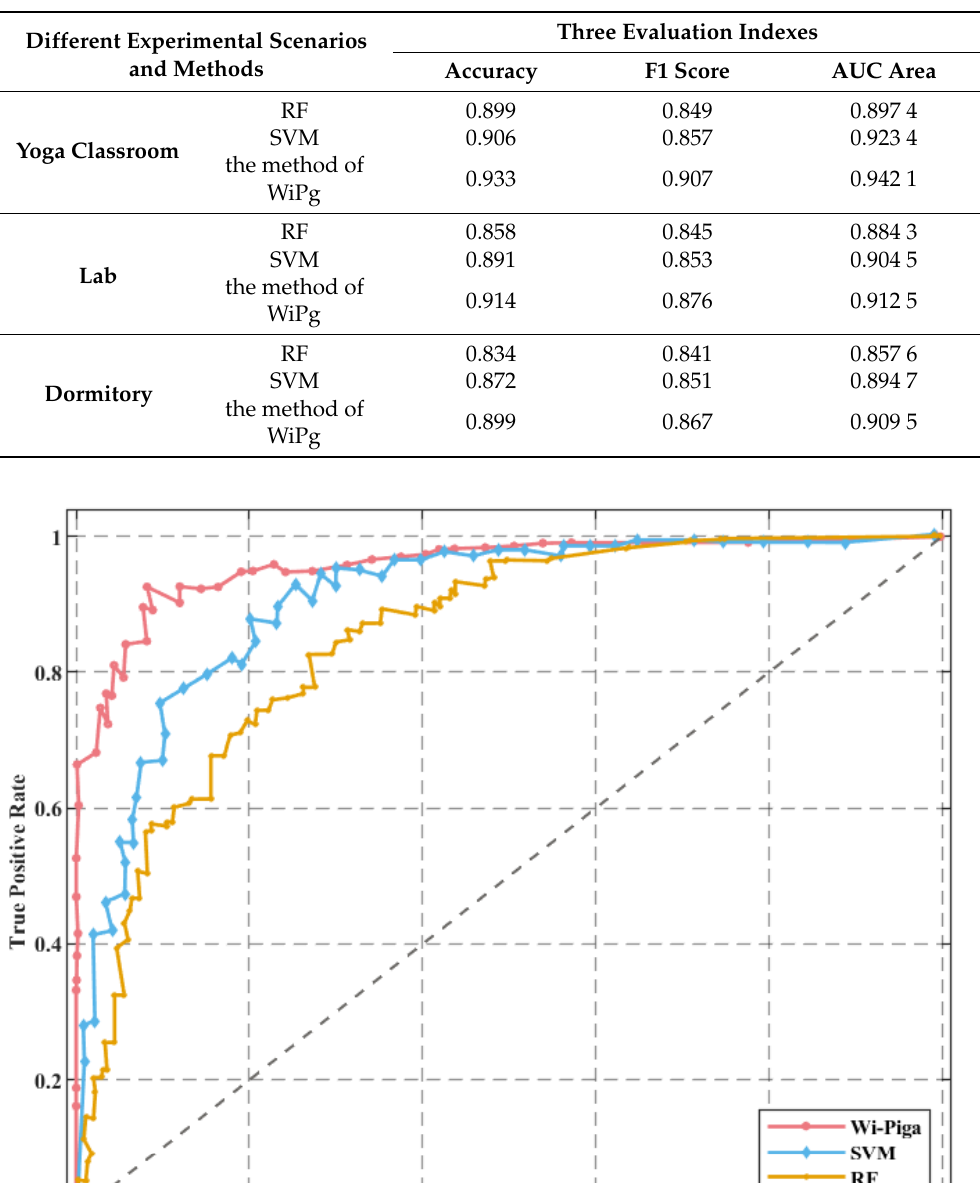
Table 2. Comparison of different recognition methods.